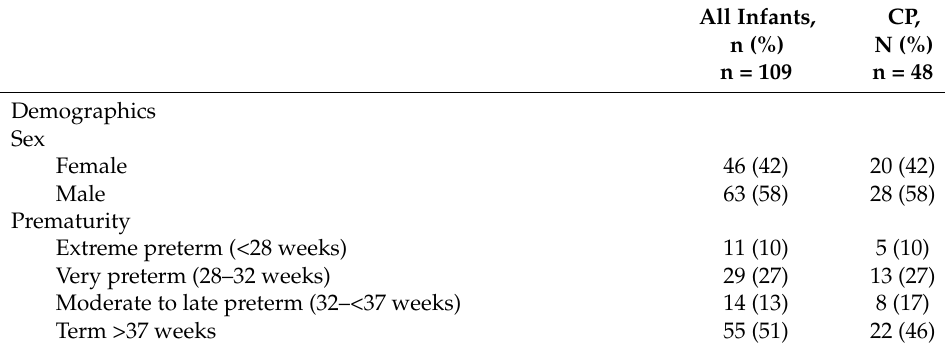
Table 2. Infant demographics and risk factors for cerebral